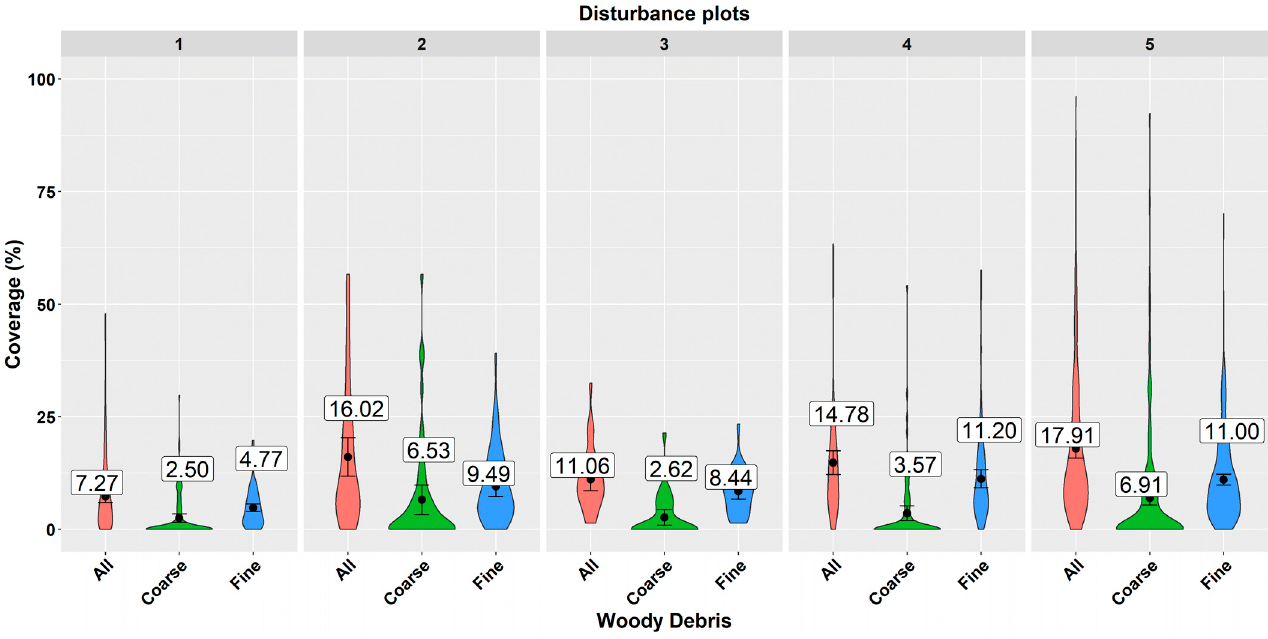
Figure 2. Deadwood coverage frequency at individual disturbed areas. A violin plot depicts distributions of numeric data using density curves. The width of each curve corresponds with the approximate frequency of data points in each region. The black point and the value represent the mean deadwood coverage and the error bar shows a 95% confidence interval of the mean.